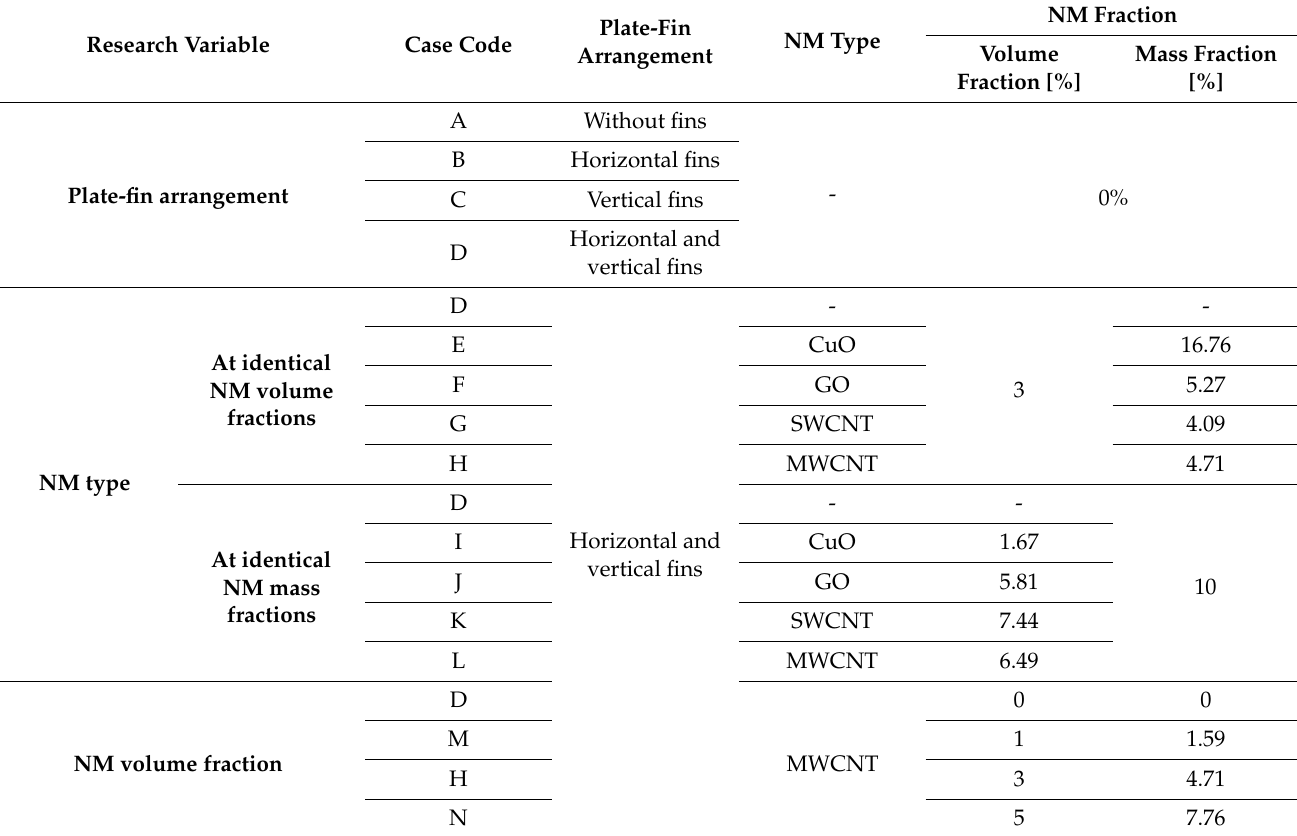
Table 2. Research variables and groups specified for the